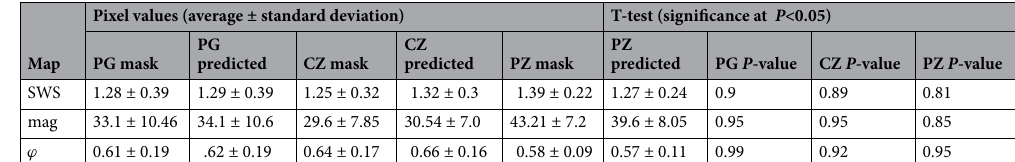
Pixel values (average ± standard deviation) Map